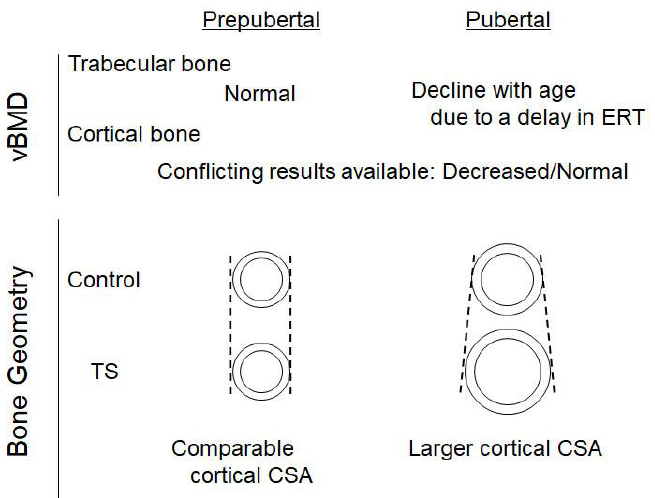
Figure 1. Summary of the skeletal characteristics of TS. Trabecular volumetric bone mineral density (vBMD) is normal in Turner syndrome (TS) during the prepubertal period, whereas it declines thereafter due to a delay in the commencement of estrogen replacement therapy (ERT). Cortical vBMD is low or normal in TS, depending on the confounding variables included in the study design. The inclusion of bone size results in the normal cortical vBMD in TS. The cortical cross-sectional area (CSA) is normal in TS during the prepubertal period, but a larger CSA is observed in TS probably due to a delay in ERT commencement, which may confer bone strength. Growth hormone treatment may also be responsible for a larger CSA in TS.